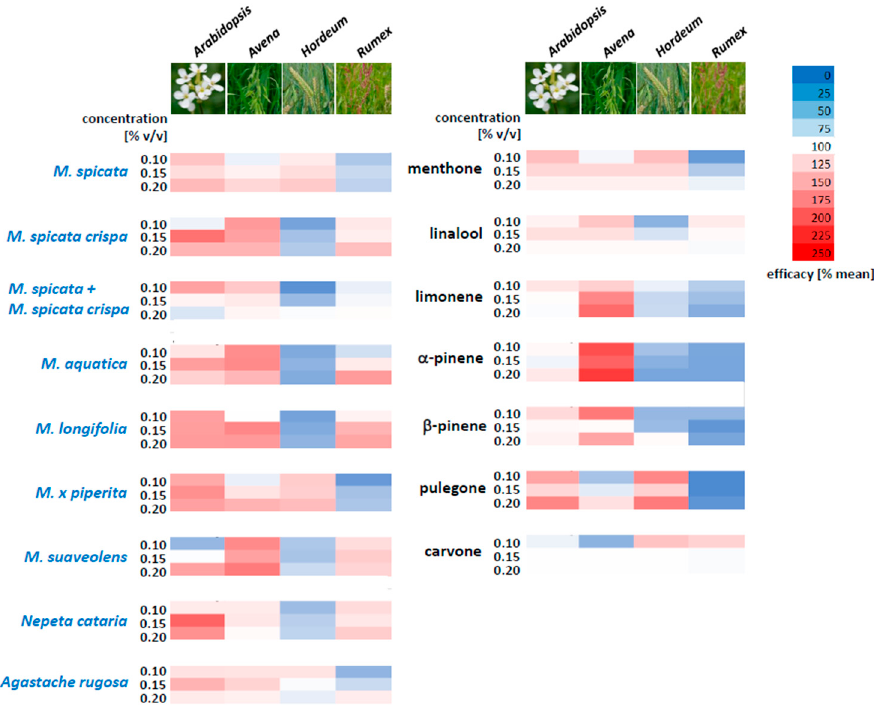
Figure 5. Efficacy spectrum for essential oils from different mints and of compounds found therein as percentage of the average inhibition over all four target species. Red colours indicate elevated efficacity while blue colours indicate reduced efficacy against the respective target species compared to the other species.